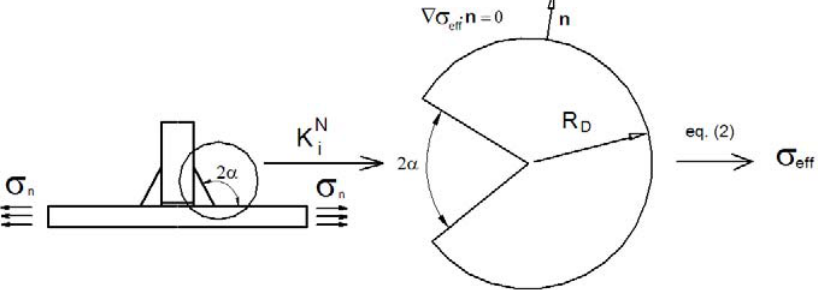
Figura 1: Geometria di